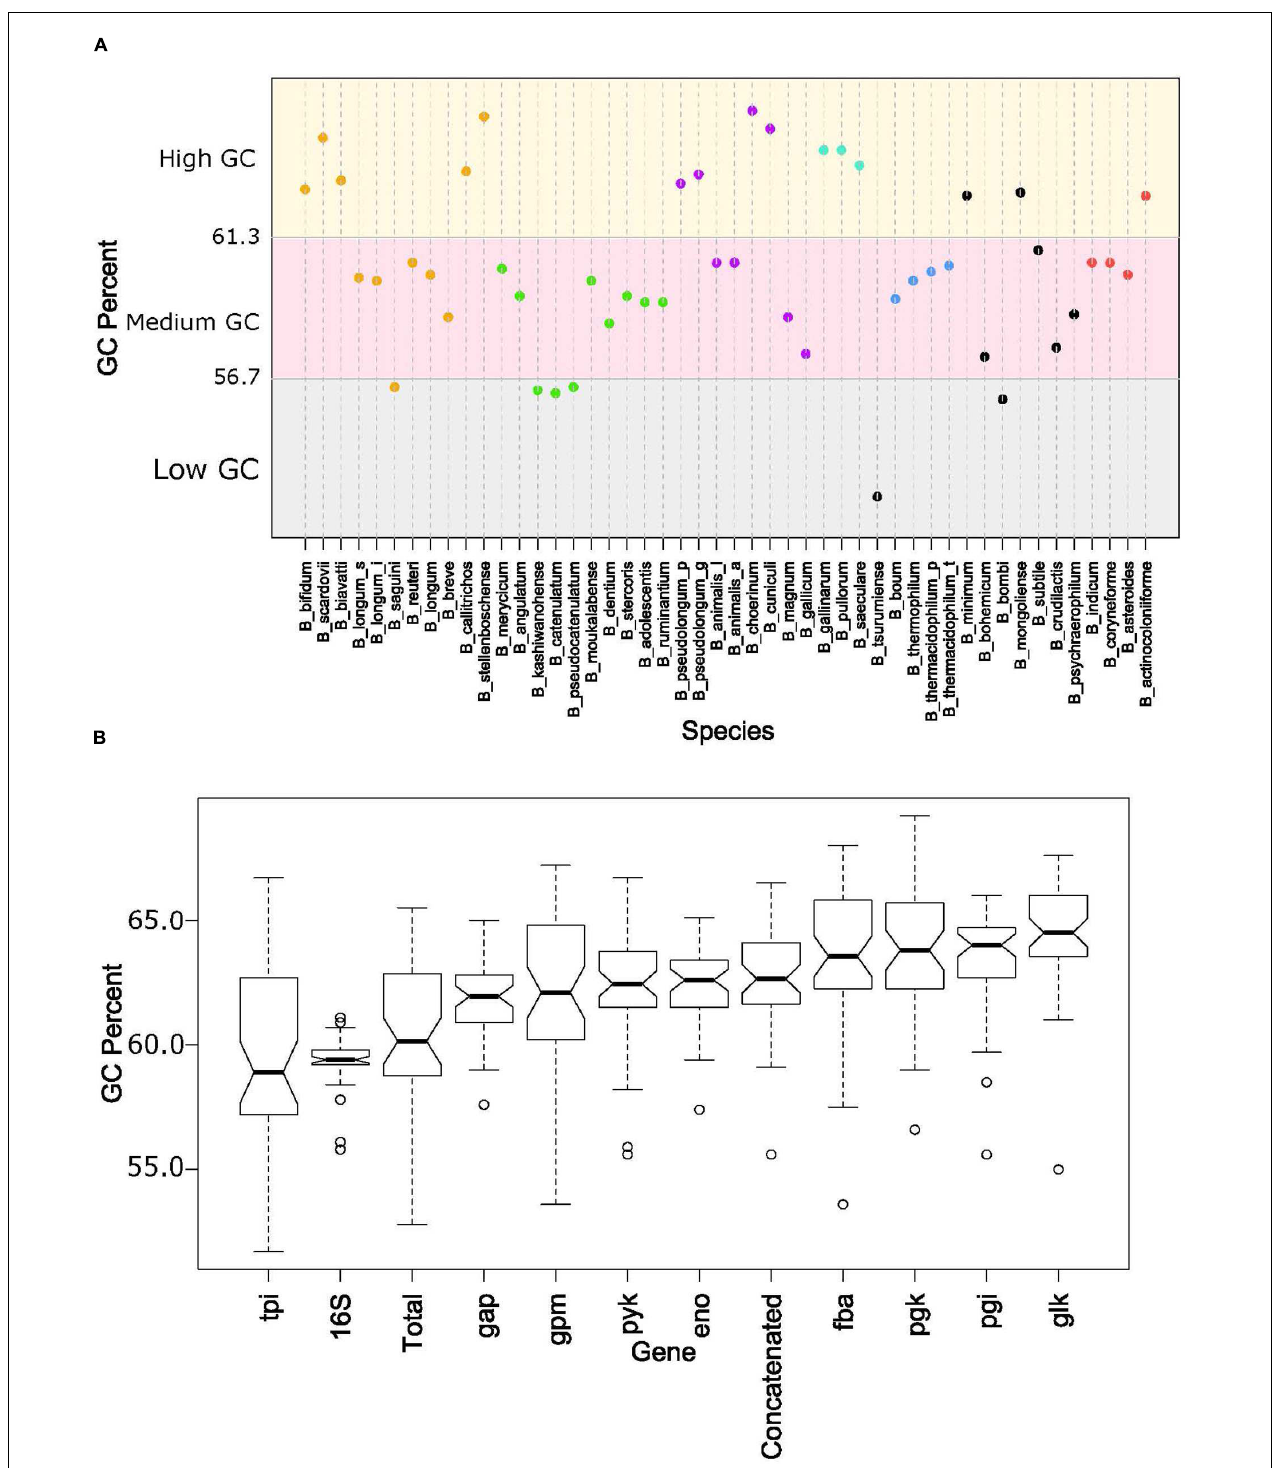
FIGURE 4 | GC content by species and glycolytic genes. (A) Shows the total GC content of each species organized by the glycolytic concatenated tree. Spectrum is split into three groups: low GC from 0.52 to 0.567 (gray), Medium GC from 0.567 to 0.613 (pink), and High GC from 0.613 to 0.66 (yellow). Phylogenetic groups are colored as follows: B. longum is orange, B. adolescentis is green, B. psdeudolongum is purple, B. pollorum is blue-green, B. boum is blue, and B. asteroides red. Species names following the naming convention from Table 1 . (B) contains notched boxplots of the GC values of each gene and total GC. Boxes are ranked in order of median. Notches that do not overlap are indicative of strong evidence of difference between two medians.